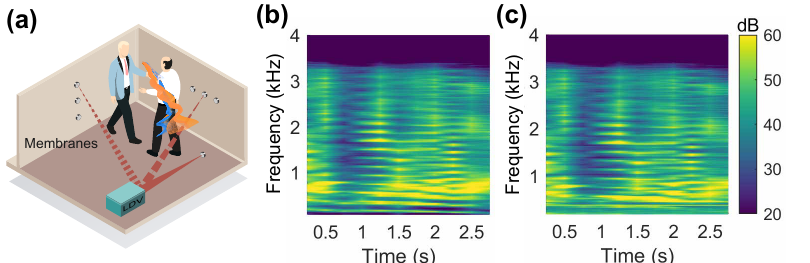
Figure 11. ( a ) Illustration of the remote speech recording system. ( b ) Spectrogram of a speech signal recorded by a microphone. ( c ) Spectrogram of the same speech signal recorded by the demonstrated acoustic sensing